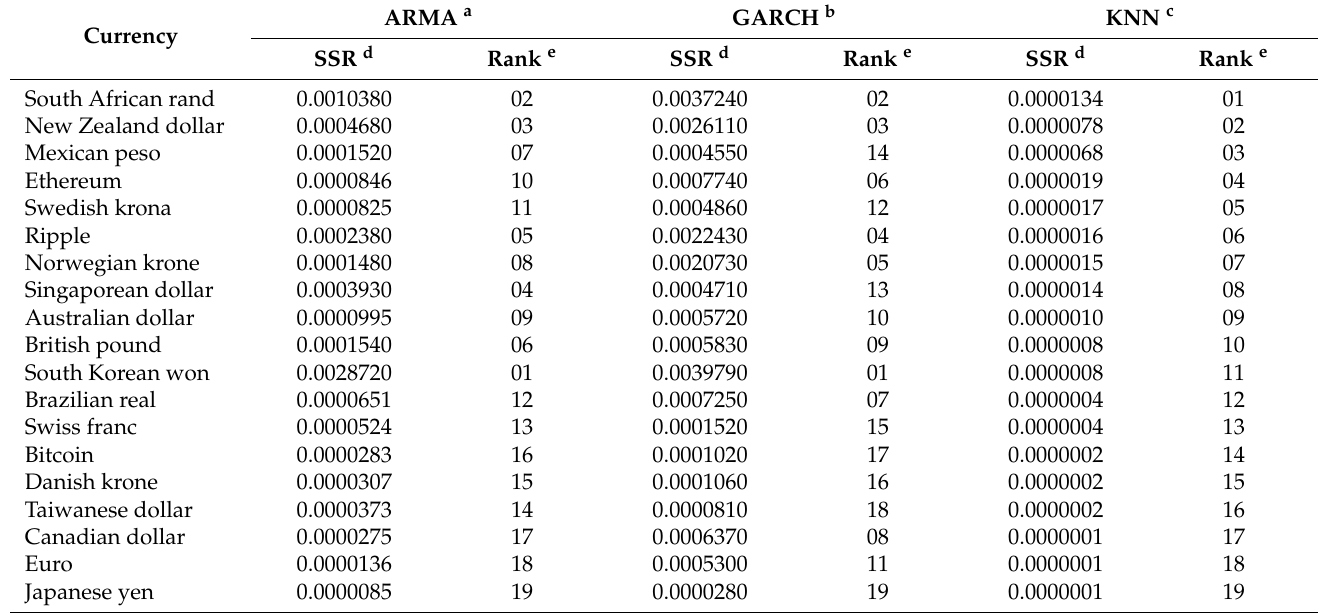
Table 6. Sum-of-squares residuals